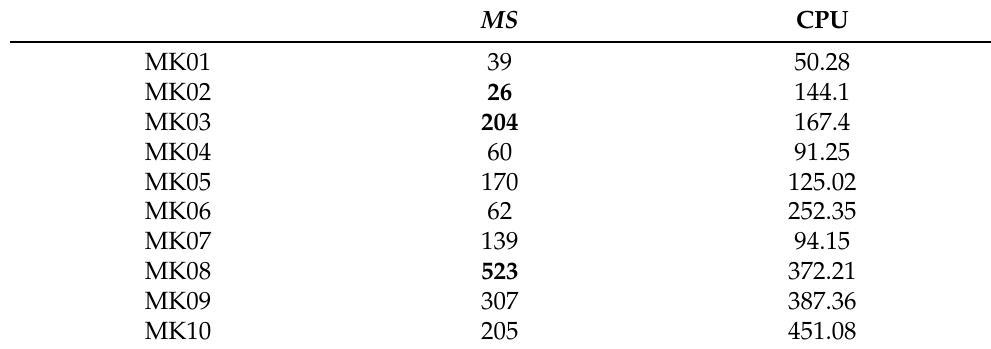
Table 9. E2L-PSO without central processing unit (CPU) reduction needed (number of visited points is 3,000,000) on Raspberry Pi B+.